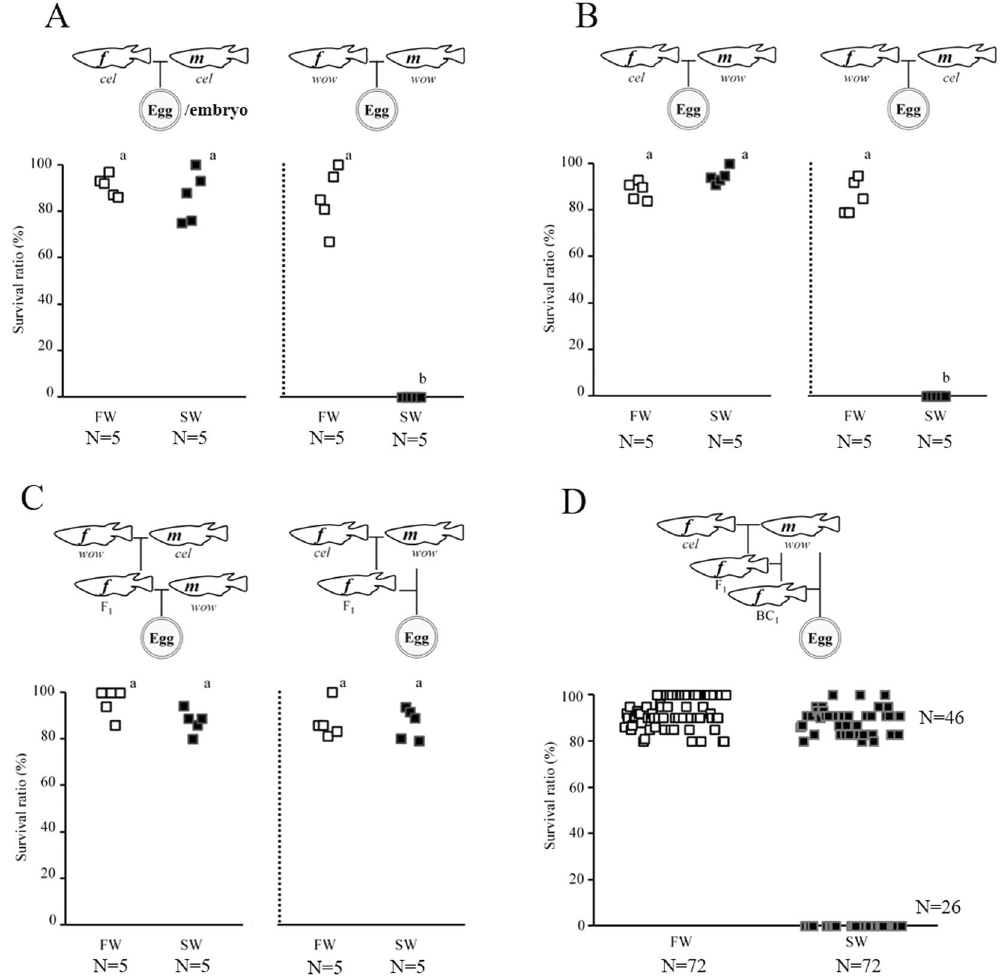
Figure 4. Survival tests of early embryos derived from Oryzias celebensis pairs ( A ) O . woworae pairs ( A ) O . celebensis females with O . woworae males ( B ), O . woworae females with O . celebensis males ( B ) the F 1 hybrid females with O . woworae males ( C ) and backcross (BC) females with O . woworae males ( D ). Mating schemes are shown above each graph. Eggs, spawned and fertilised in fresh water, were transferred to fresh water (FW) or sea water (SW) after 1 h (1 to 2 cell stage). Survival ratios 24 h after fertilisation were calculated at least 20 eggs/ embryos from five pairs ( A – C ) or 72 pairs ( D ). Open and closed squares indicate survival ratios of embryos from each female. Groups with different letters in each graph are significantly (P < 0.05) different. f , female; m , male; cel , O . celebensis ; wow , O . woworae